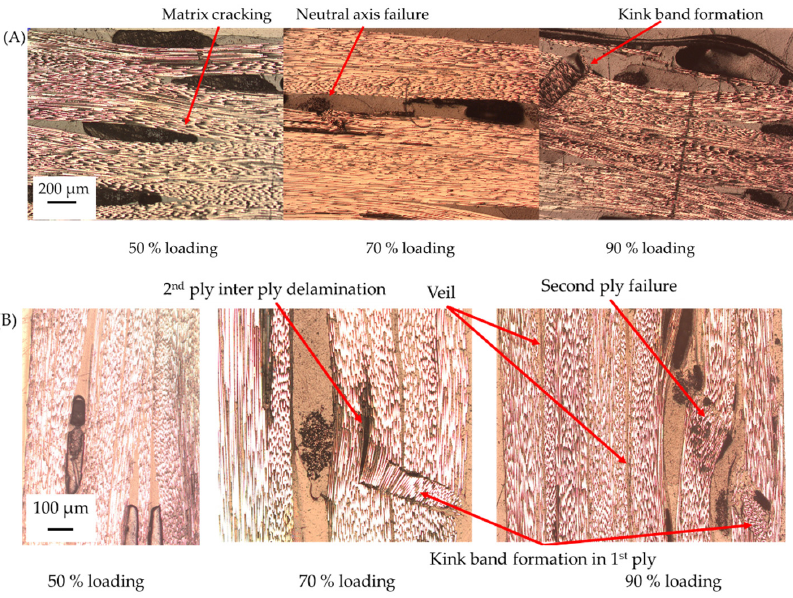
Figure 8. ( A ) CF and ( B ) CFT fibre failure evaluation from loading conditions 50, 70, and 90%. The veil toughening and carbon fibre labelled CFT was shown to have a higher strain of 0.3% before failure. However, 20,000 additional cycles elapsed before CF failed cata ‐ strophically. At 90% maximum loading, the CF and CFT had experienced catastrophic failure in all samples, with an average modulus of 10.23 GPa for CFT and 25.46 GPa for CF. CFT’s 90% higher modulus suggests that the fibre yield is not prevented with veil toughening at higher amplitudes. Most fibre failure occurred at 70%, with total failure at 90% maximum loading. With failure, the veil samples encountered a large drop in modu ‐